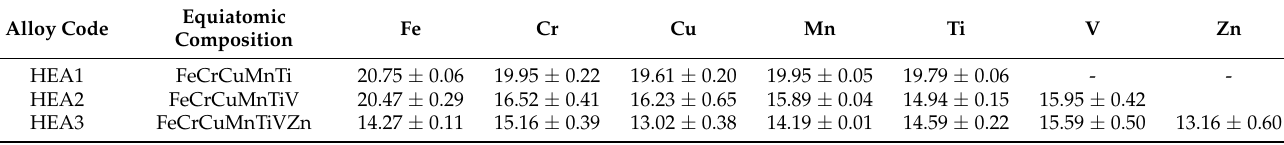
Table 2. Chemical composition in at. wt.% of three developed HEAs taken in several regions by HRSEM-EDS. Alloy